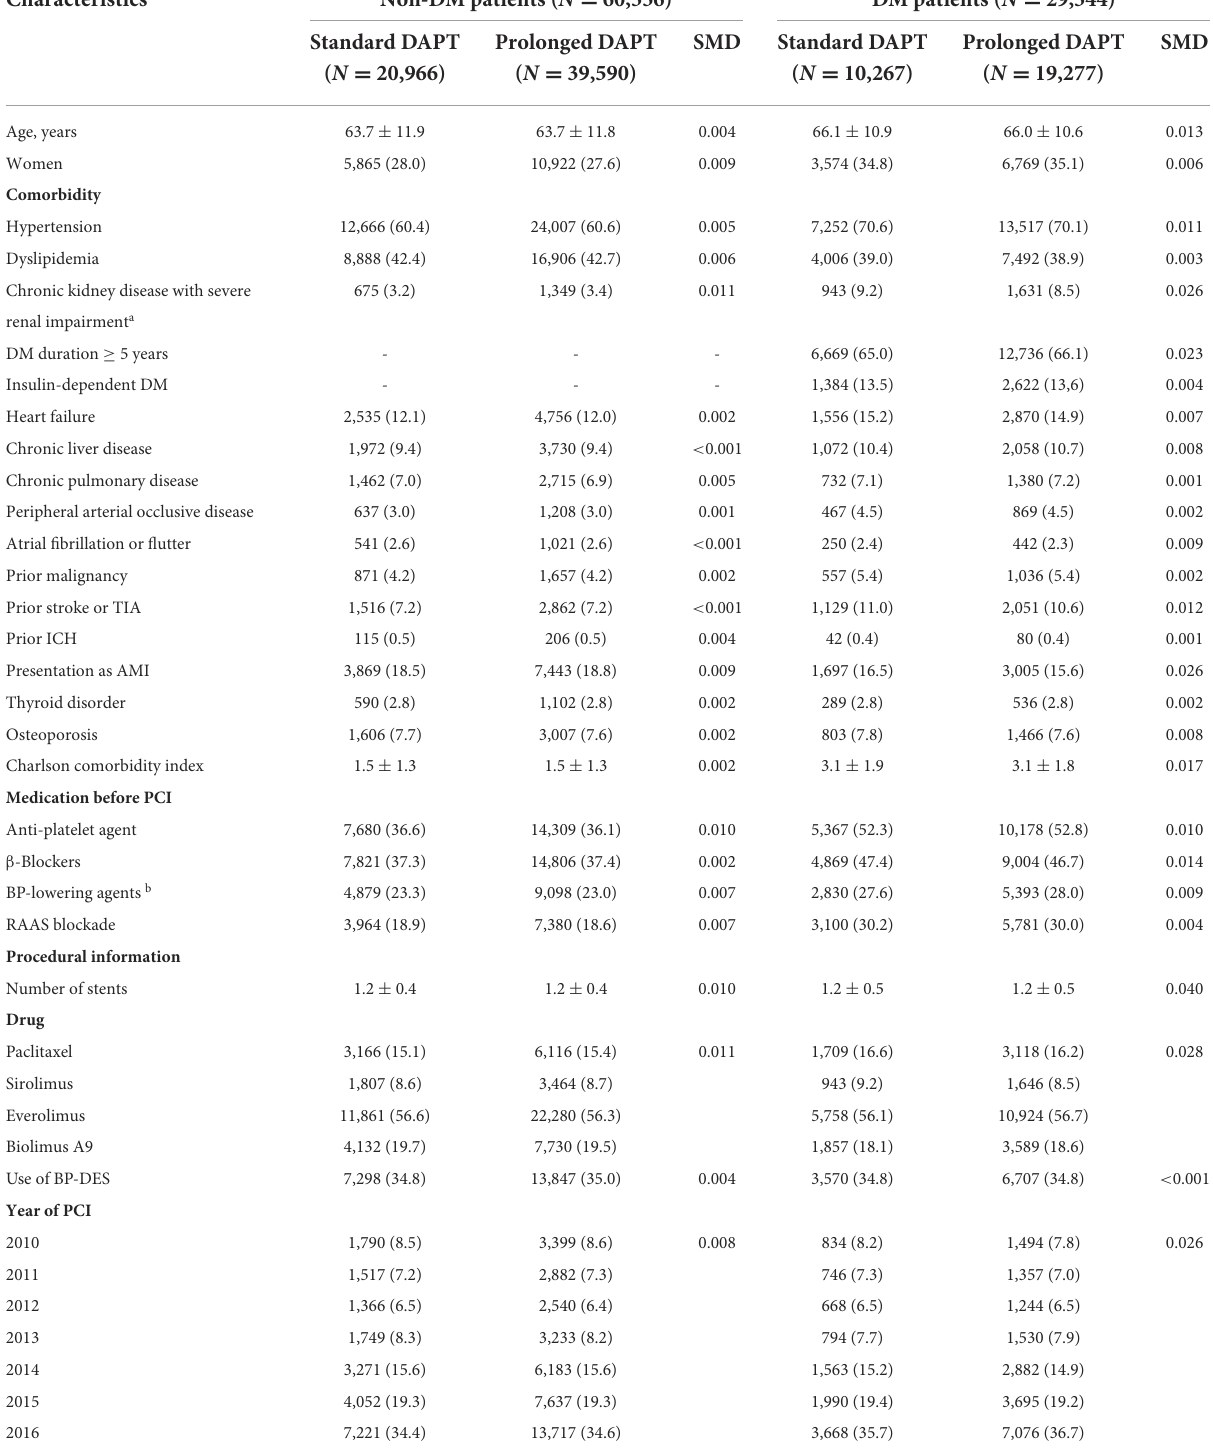
TABLE 1 Baseline characteristics and medications in patients with and without DM.